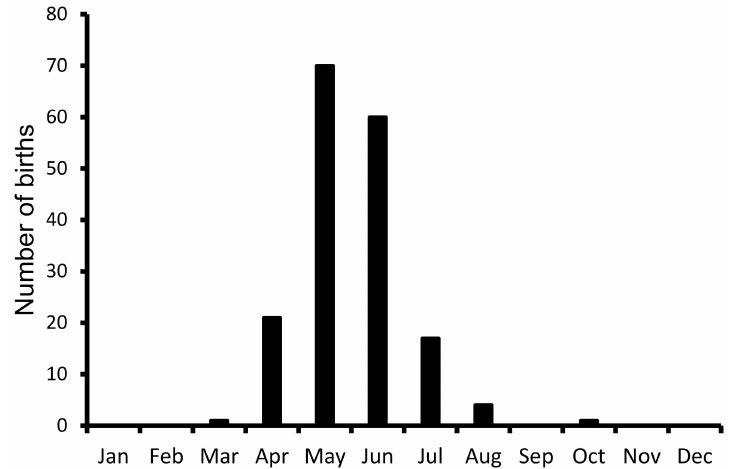
Figure 6. Distribution of births of pigmy hogs in PHCP, Guwahati. About 172 births were recorded between April 1996 and July 2020, including those of three wild-caught